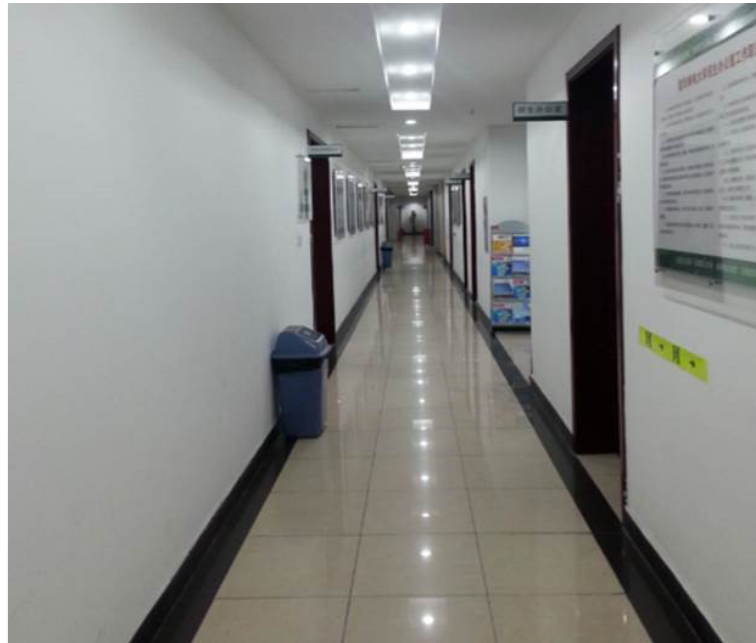
Figure 6 . Experimental